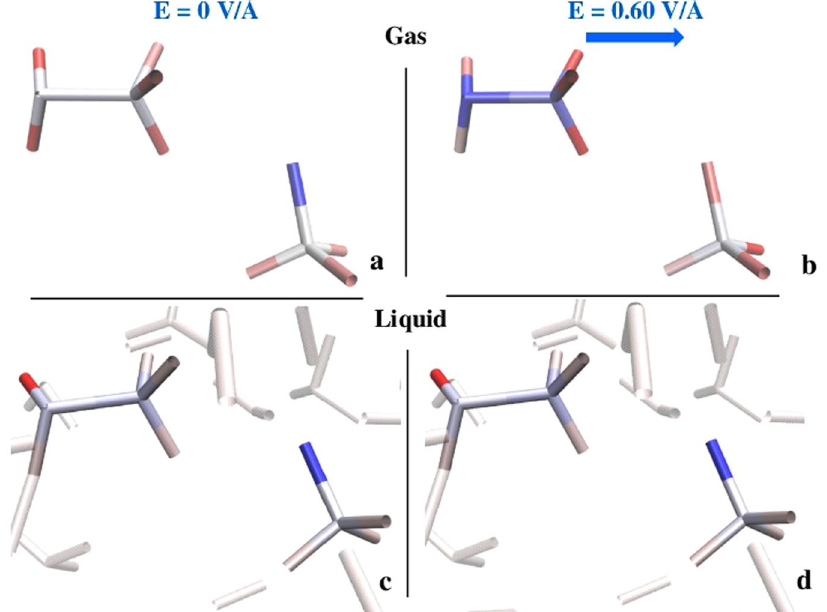
Figure 5. Löwdin population analysis of CH 3 OH 2 + and CH 3 O − in the gas phase ( a , b ) and in the liquid phase ( c , d ) without ( a , c ) and with an external electric field at a strength of . 0 60 V/Å ( b , d ). The blue arrow shows the field orientation. The coloring method follows the atomic electron populations shown in Table S1. In particular, the atomic population values relative to the expected ideal atomic valence population ( i . e ., 6 for the oxygen, 4 for the carbon, and 1 for the hydrogen atoms) are plotted. Deep blue coloration indicates a strong positive value with respect to the expected ideal valence population; deep red coloration illustrates a strong negative value with respect to the expected valence population; white coloration stems from estimated values very close to the standard ideal electronic population of each atomic